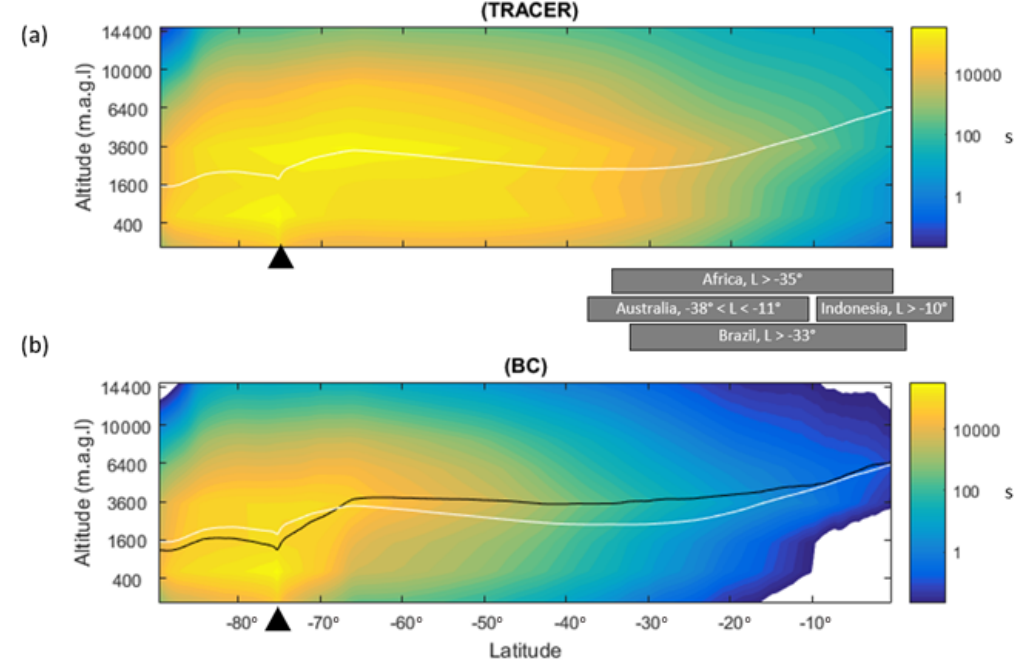
Figure 13. The residence time of 60000 50d FLEXPART back trajectories arriving at Dome C in 2008–2013 as a function of latitude and altitude above ground level. The residence time is color-coded from blue to yellow to show increasing time spent in each grid cell. (a) The residence times of the inert tracer back trajectories. White line: the average altitude of trajectories at each latitude. (b) Same as in panel (a) but for the BC tracer. Black line: the average altitude of the BC tracer; the white line is for comparison average altitude of the inert tracer. The black triangle shows the latitude of Dome C (75 ◦ 06 (cid:48) S). The grey text boxes between (a) and (b) show the approximate latitude range of some major BC-emitting regions.